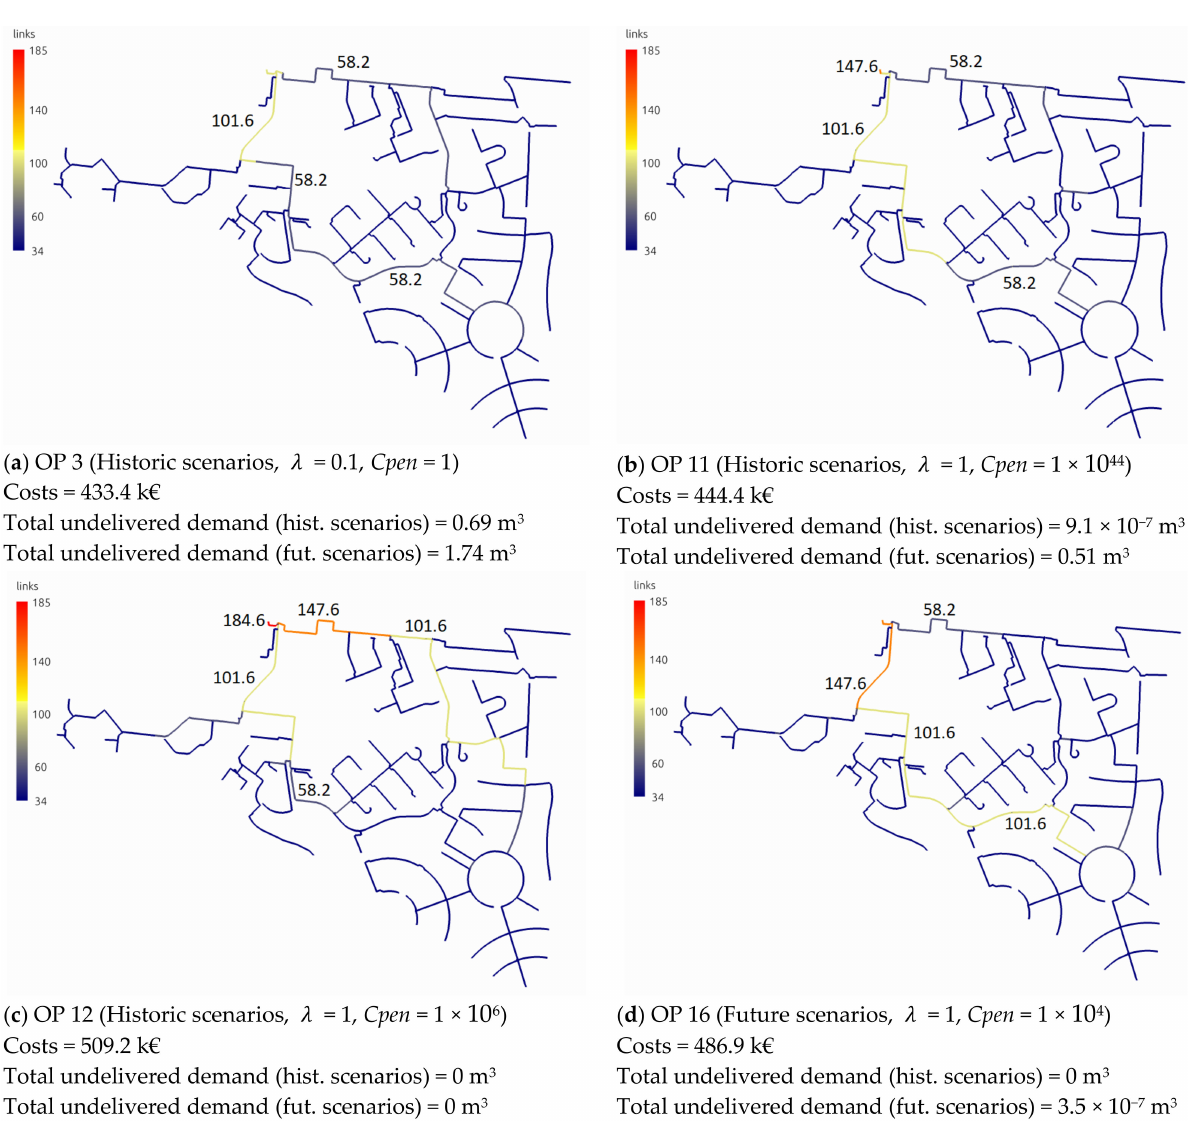
Figure 9. Design solutions obtained for different optimization problems, considering different scenarios (historic or future) and different values for the penalty coefficient ( Cpen ) and variance factors ( λ ). The different colors indicate the pipe diameters, ranging from 34 to 184.6 mm. The diameters along some of the paths (constituted by several pipes) are indicated with numbers. Designs with lower costs are not able to fully satisfy the demands for both historic and future scenarios (for instance, solutions ( a , b )). By increasing more pipe diameters, design costs increase, but it is possible to fully satisfy demand under all scenarios, both historic and future (solution ( c )), or for all historic scenarios and almost all future scenarios (solution ( d )). This provides the decision maker with the information on how do dimension the network to achieve a certain level of